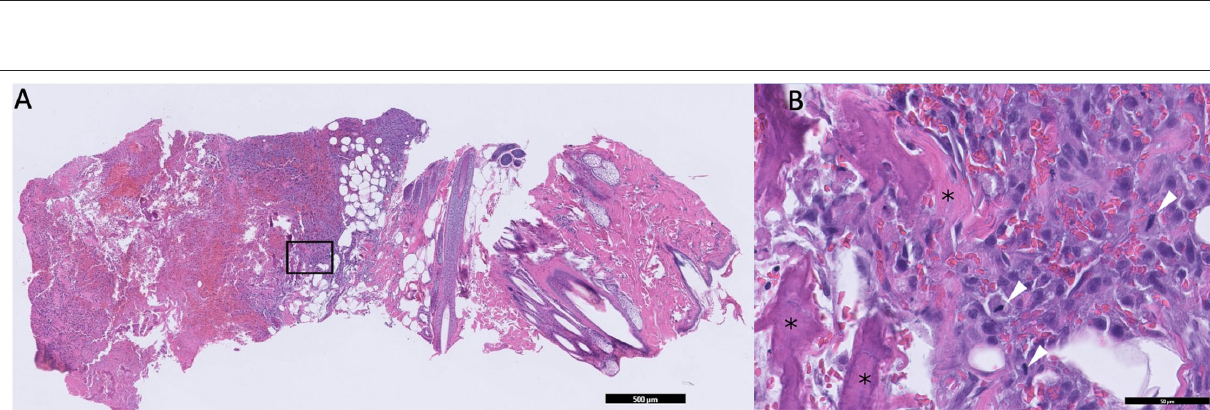
FIGURE 1 | (A) Transverse CT and positron emission tomography (PET)/CT (B) images of the large left 9th rib lesion and the subcutaneous nodule (white asterisk). Note the marked avidity of bone associated with the primary bone lesion and the subcutaneous nodule after intravenous administration of flouride-18 fludeoxy glucose (18F-FDG) in the PET/CT image.